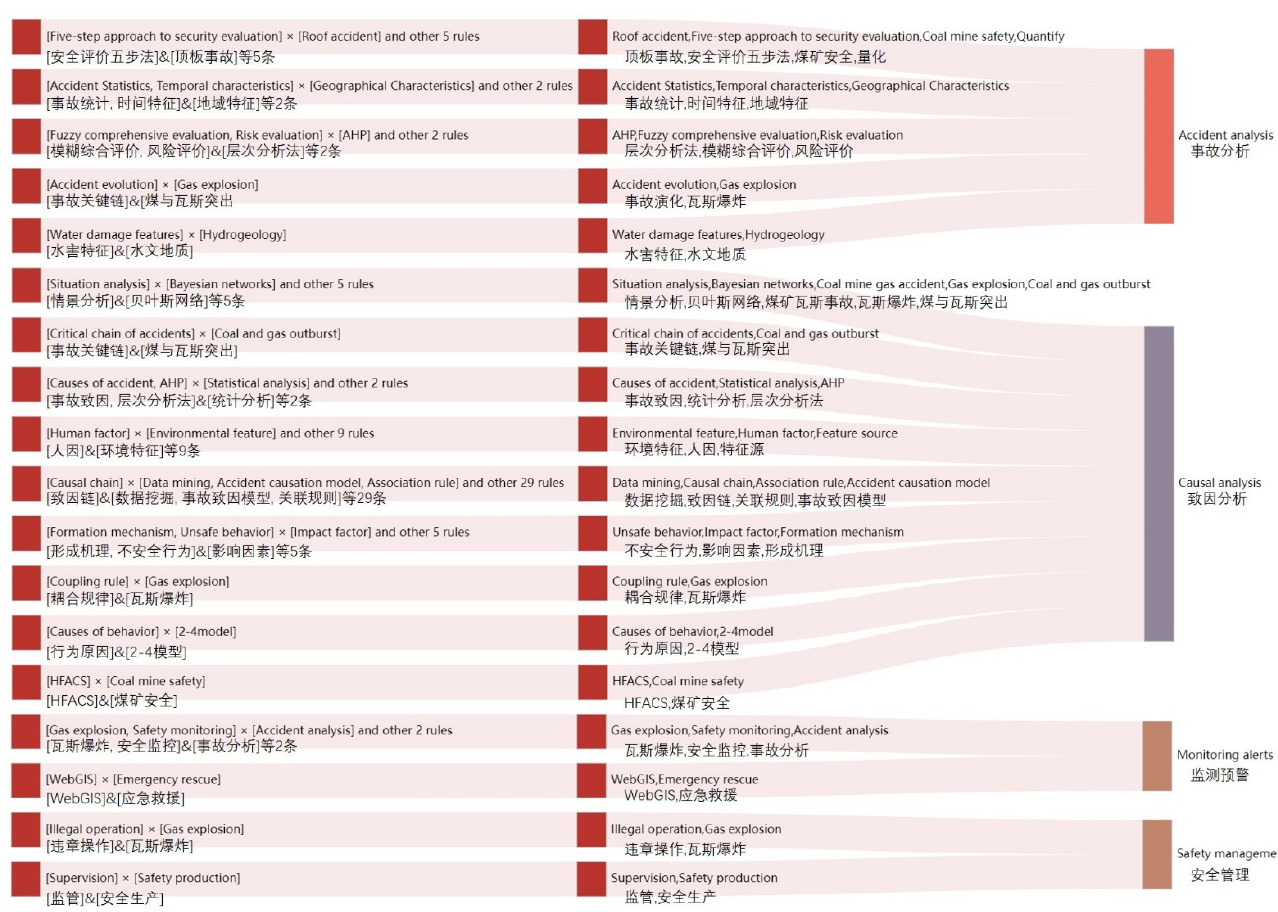
Figure 9. Strong association rules and category of Chinese keywords.